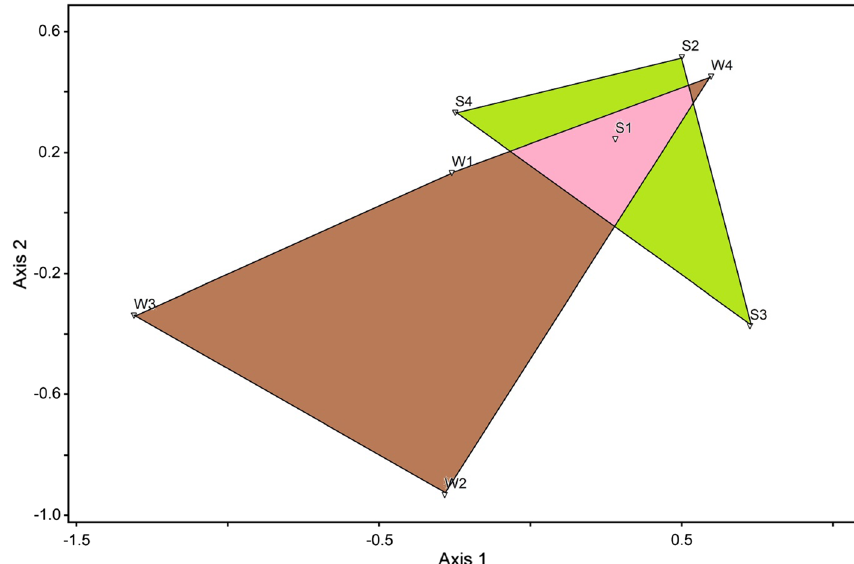
Fig. 3 n -MDS ordination (stress value 0.12) highlighting varia- tion of macrophyte communi- ties across sites and seasons. Polygons indicate the two seasons: green—summer and